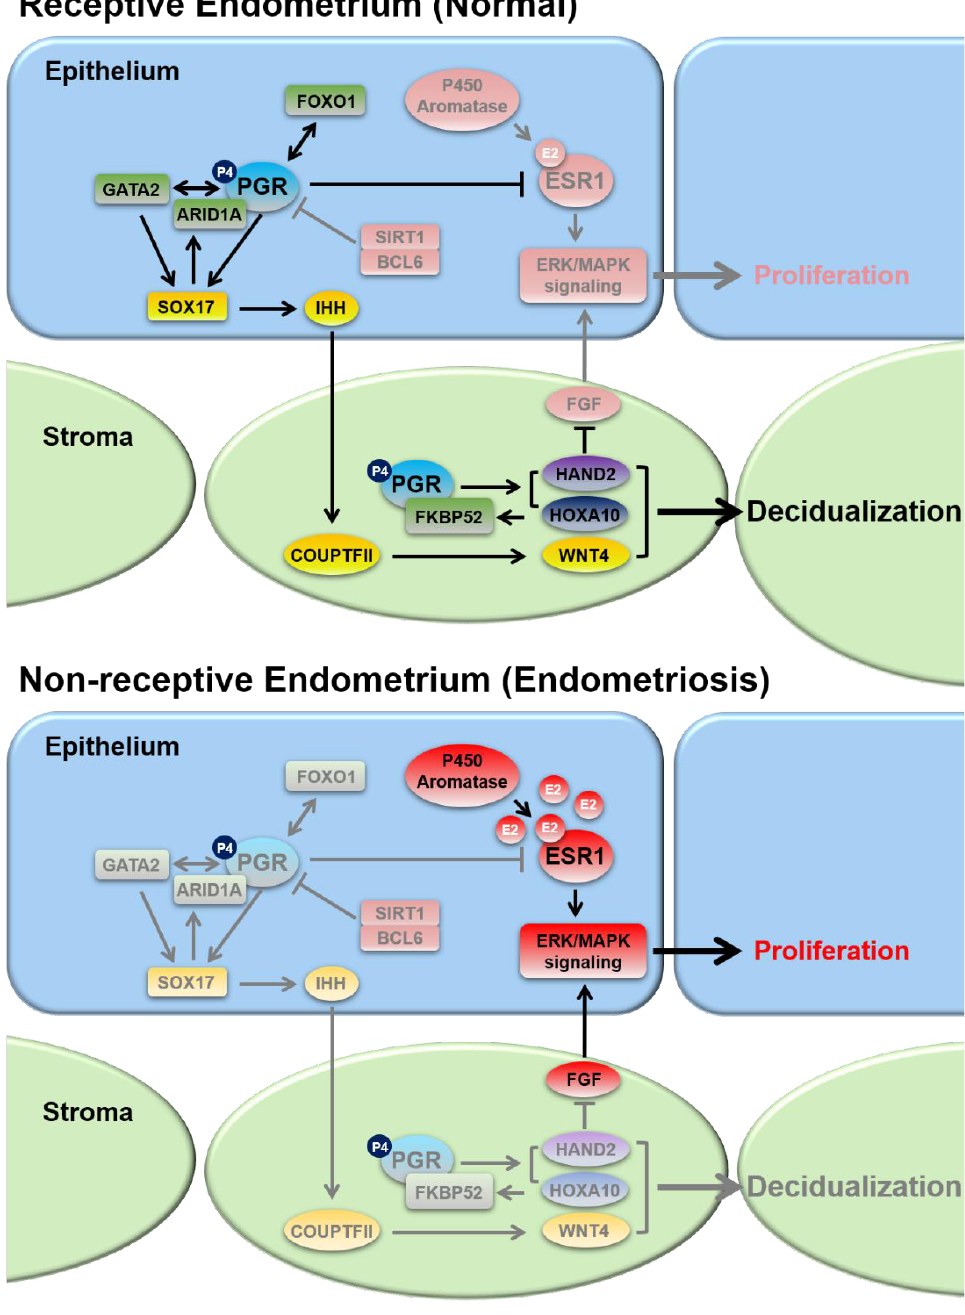
Figure 1. Schematic diagram illustrating the primary known signaling pathways and transcriptional regulators involved in P4 and E2 governance of endometrial epithelial-stromal crosstalk that are dysregulated in endometriosis. P4 resistance and E2 dominance in endometriosis results in epithelial proliferation and defective decidualization that can compromise endometrial function. Abbreviations: ARID1A, AT-rich interaction domain 1A; BCL6, B cell CLL / lymphoma 6; COUPTFII, chicken ovalbumin upstream promoter-transcription factor II; E2, estrogen; ERK, extracellular signal-regulated kinase; ESR1, estrogen receptor 1; FGF, fibroblast growth factor; FKBP52, FK506 binding protein prolyl isomerase 4; FOXO1, Forhead box O1; GATA2, GATA binding protein 2; HAND2, heart and neural crest derivatives expressed 2; HOXA10, homeobox protein-A10; IHH, Indian hedgehog; MAPK, mitogen-activated protein kinase; P4, progesterone; PGR, progesterone receptor; SIRT1, Sirtuin 1; SOX17, sex determining region Y box 17; WNT4, Wnt family member